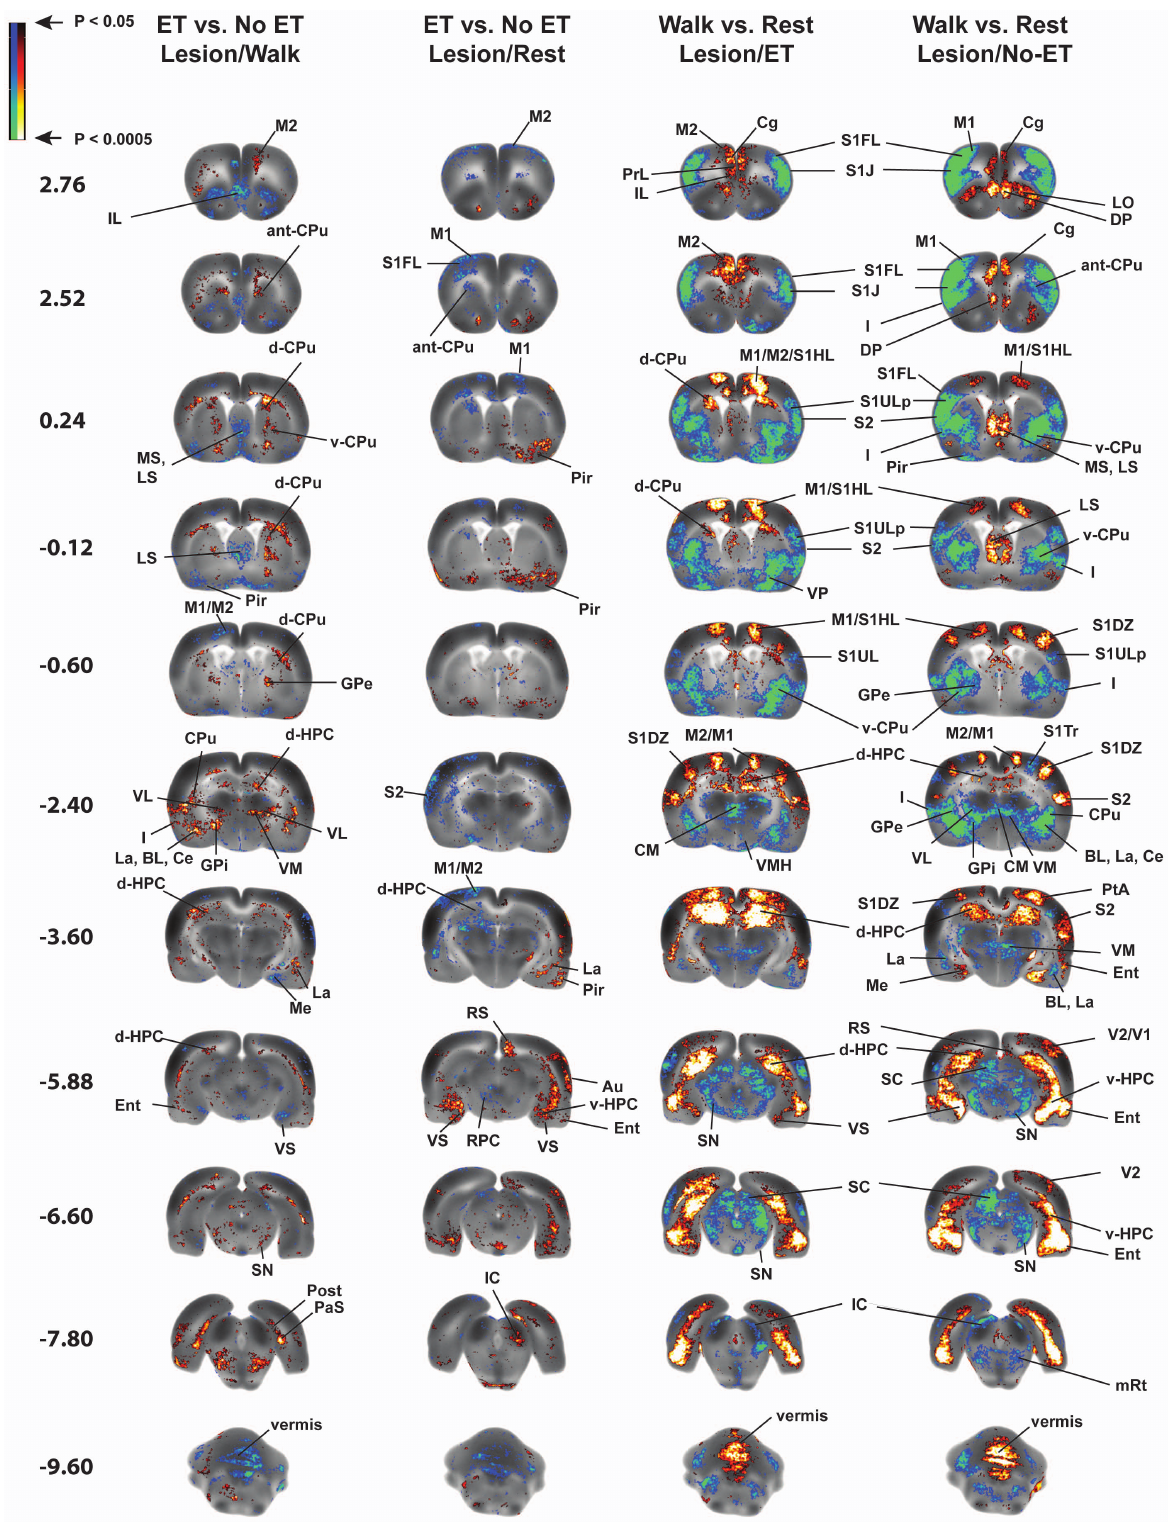
Figure 6. Effects of prior exercise training (ET) on functional brain activation. Shown are statistically significant differences in activation during acute treadmill walking (ET/Walk, n =11, No-ET/Walk, n =9) or at rest (ET/Rest, n =12, No-ET/Rest, n =10) in rats with bilateral striatal lesions. Depicted is a selection of representative coronal slices (anterior–posterior coordinates relative to bregma). Colored overlays show statistically significant positive (red) and negative (blue) differences (voxel level, P , 0.05). Abbreviations are those noted in the legend of Fig. 5.